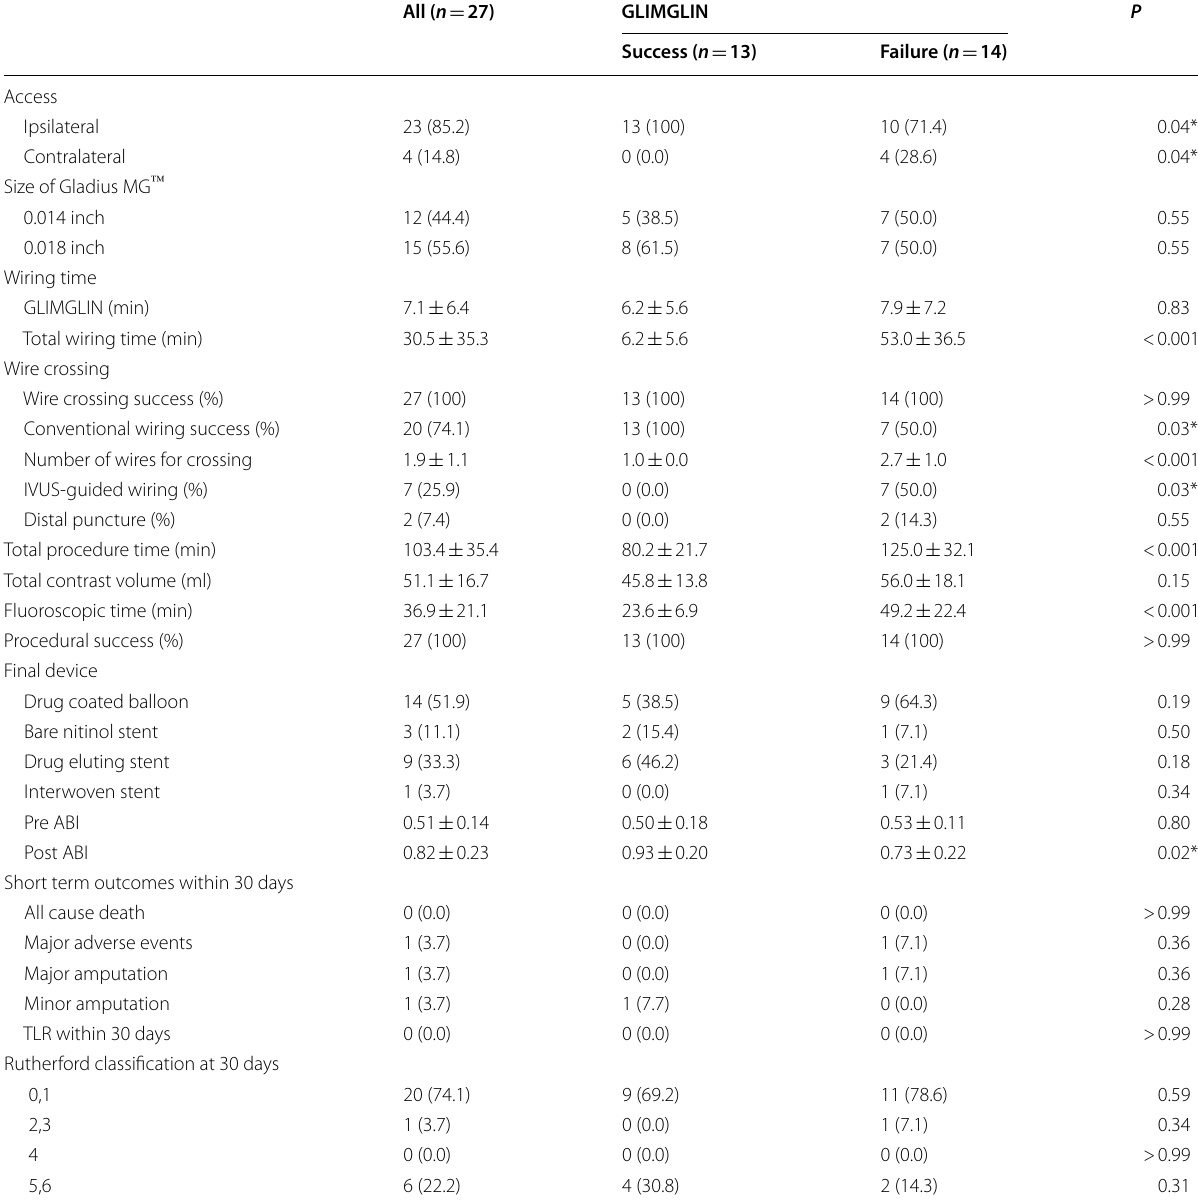
Table 3 Procedural